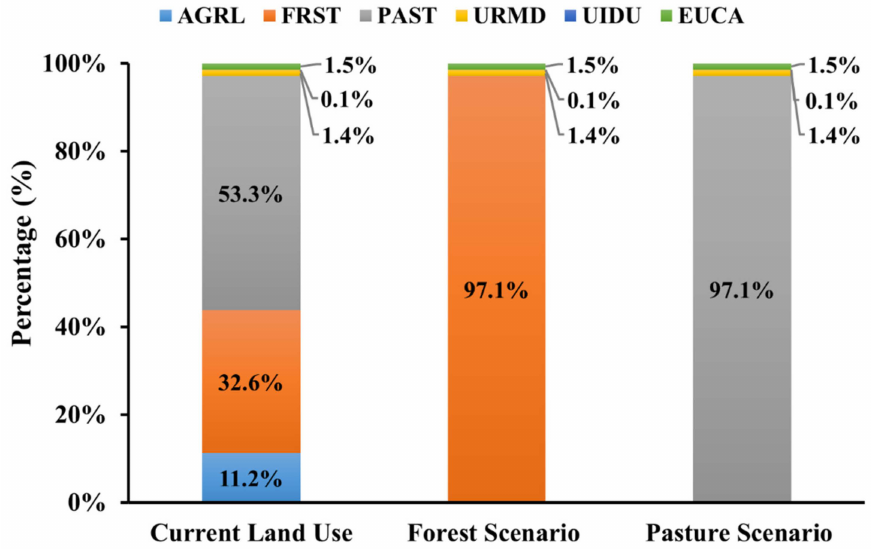
Figure 4. Land use proportions for current land use and the scenarios of forest and pasture in the Uberaba River basin. In the forest scenario, Agricultural Land-Generic (AGRL) and Pasture (PAST) change to Forest-Mixed (FRST), and in the pasture scenario, Agricultural Land-Generic (AGRL) and forest-evergreen (FRSE) change to Pasture (PAST). Legend: Residential-Medium Density (URMD), Industrial (UIDU) and Eucalyptus